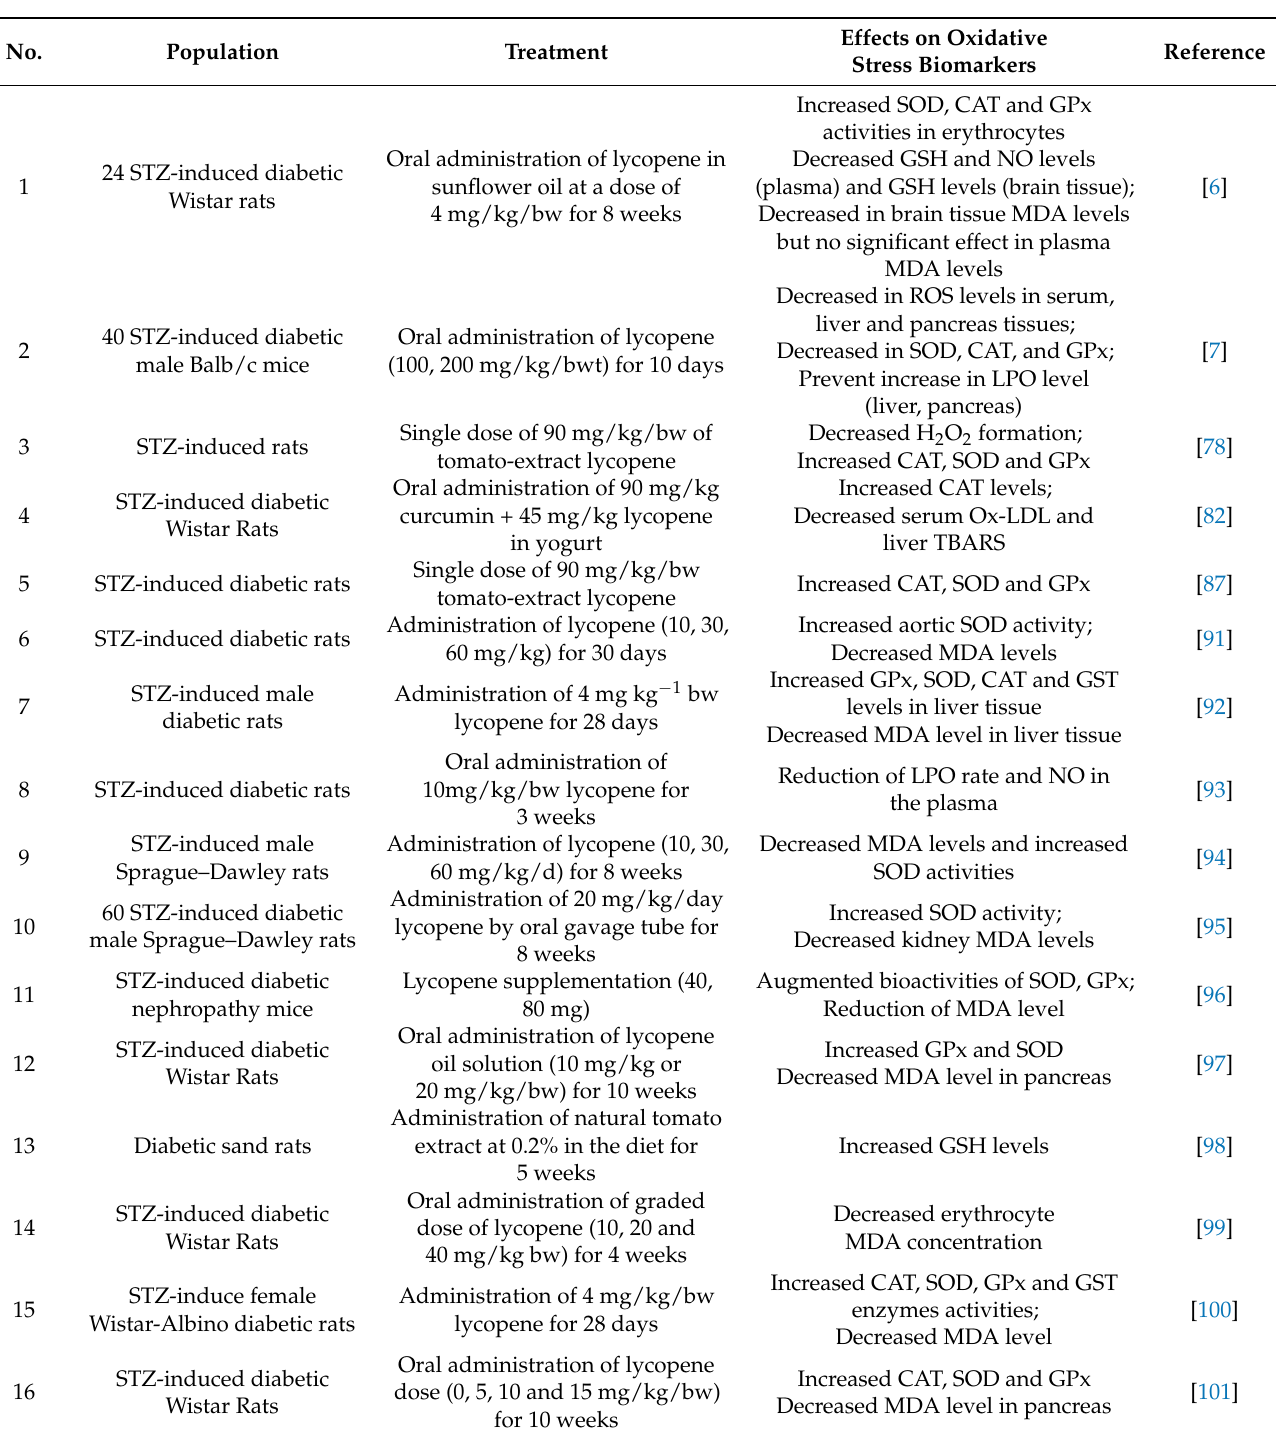
Table 5. Animal studies on the effects of lycopene on antioxidant and oxidative stress biomarkers in